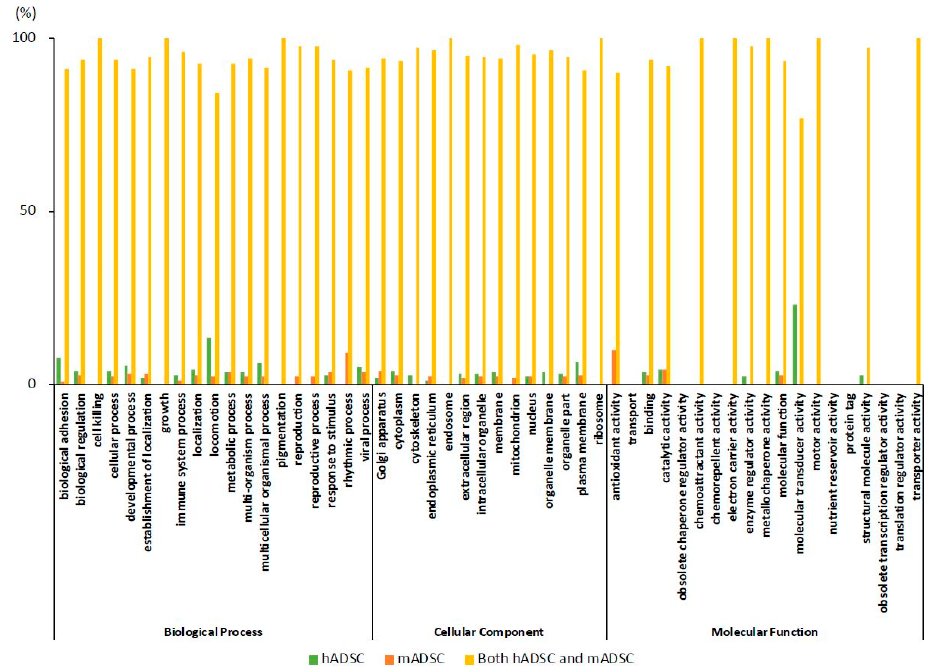
Figure 4. The GO composition ratio of the number of proteins in the hADSC, mADSC, and both hADSC and mADSC groups. The values calculated by dividing the number of proteins in the GO-classified hADSC, mADSC, both hADSC and mADSC groups by the total number (hADSC + mADSC + both hADSC and mADSC) are displayed (%). The protein counts in the hADSC, mADSC, and both hADSC and mADSC groups in Figure 3 are shown after the percentage was calculated. 10%.